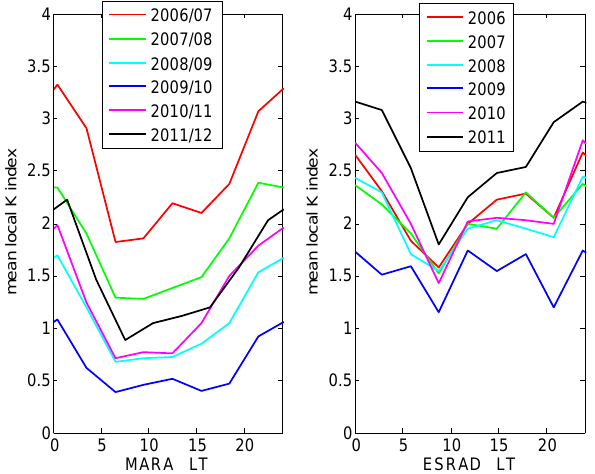
Fig. 3. Average K indices for each PMSE season (June/July for ESRAD, December/January for MARA) as a function of local (so- lar) time. K index used for MARA is from Leirvogur, Iceland, for ESRAD from Kiruna, Sweden. (Note that no measurements were made by MARA during the 2008/2009 season).